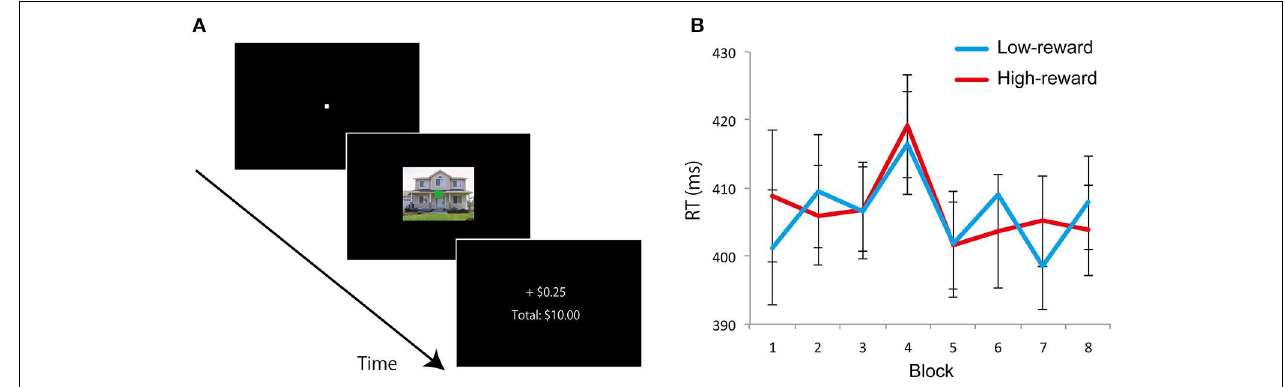
category of background images (e.g., “house”) was associated with a high probability (0.8) and the other category (e.g., “building”) was associated with a low probability (0.2) of winning reward. (B) Mean RT of correct trials with low-reward and high-reward background image in each block. Error bars denotes standard error of the